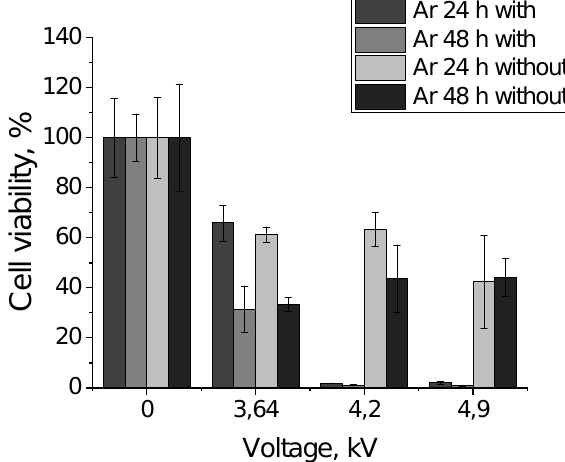
Figure 13. Number of survivals of A549 cells in % for cases with and without the grounded substrate after 24 and 48 h of direct argon CAP treatment, 1 min, at U = 3.6, 4.2 and 4.9 kV, gas flow rate v = 4